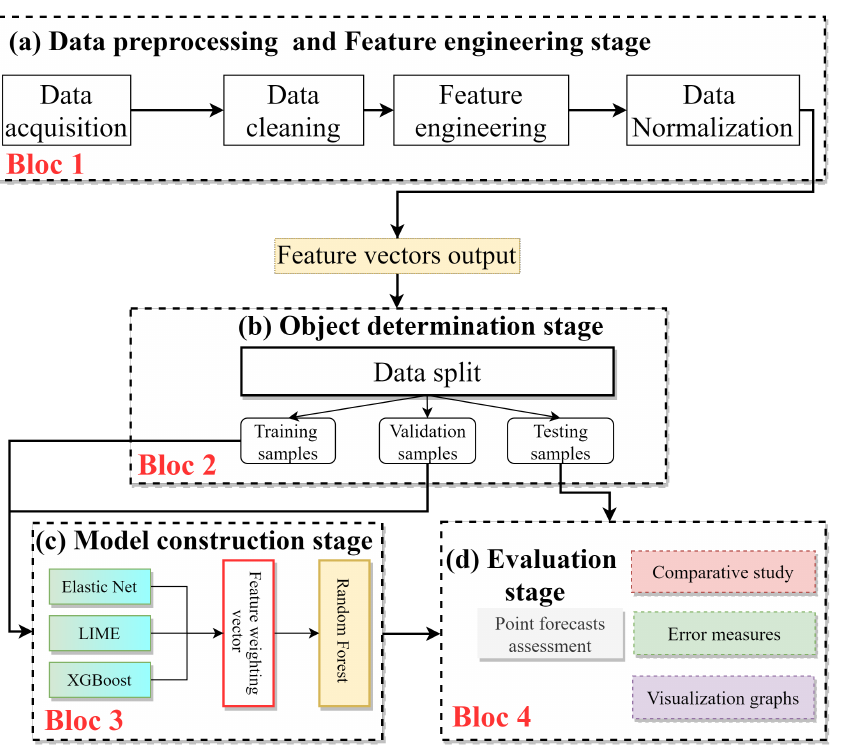
Figure 9. Structure of the proposed methodology with ( a ) data preprocessing and feature engineering, ( b ) object determination, ( c ) model construction ( d ) evaluation. Table 3. Hyperparameters settings for reference